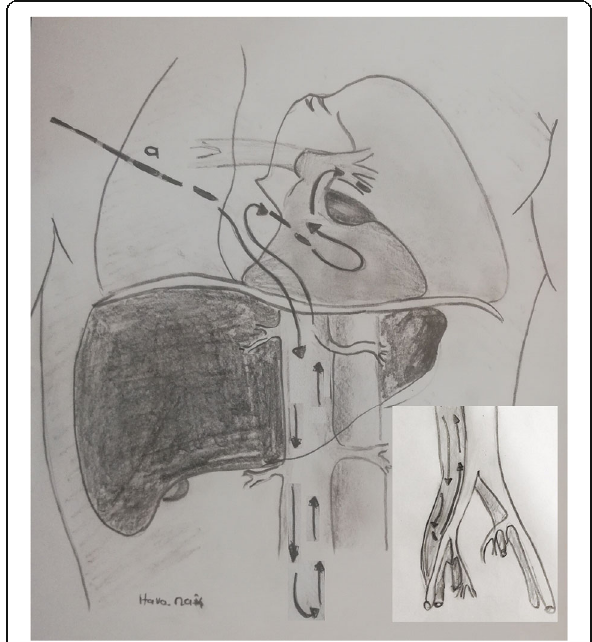
Fig. 3 Path of the bullet with an insert showing its distal-most location in right internal iliac